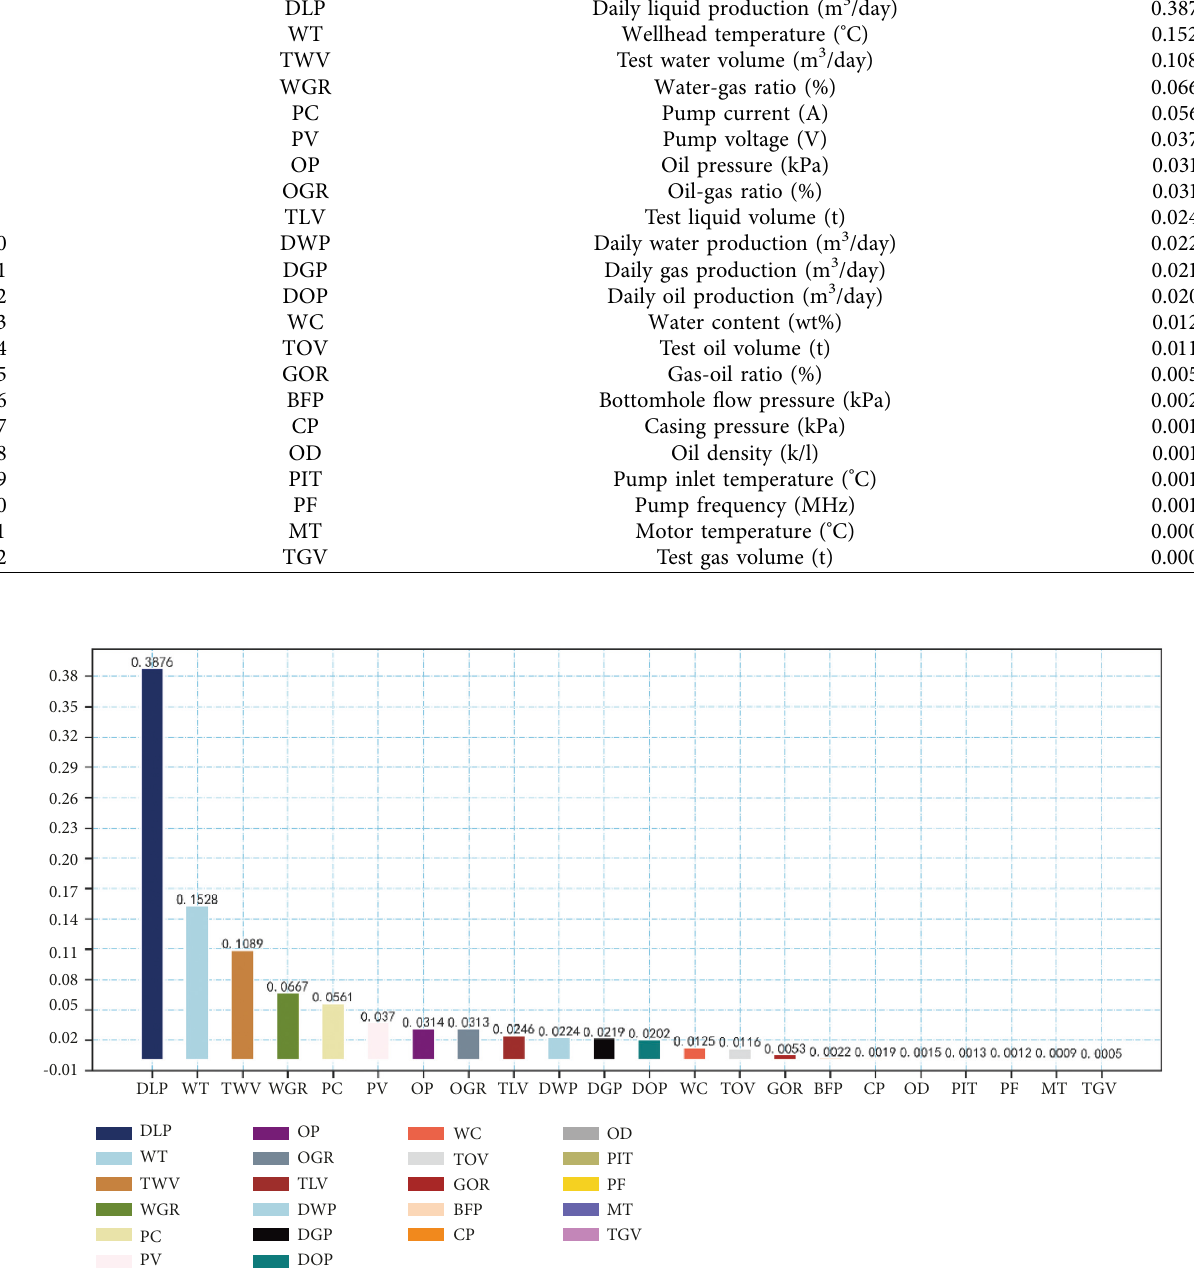
Figure 7: Ranking the importance of variables in ESP. Table 3: Parameters’ selection.